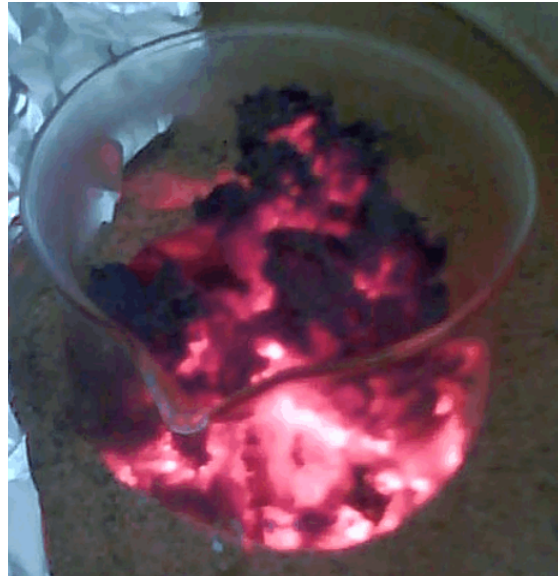
Figure 1. MFO-Gly auto